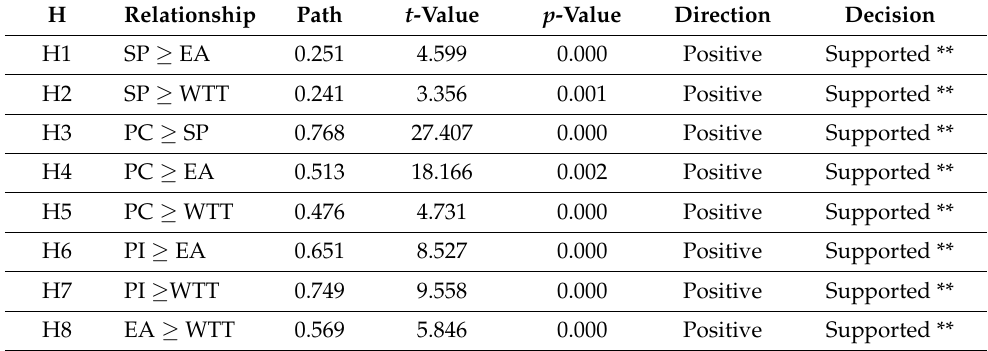
Table 7 and Figure 3 present a summarized result, which indicates that: